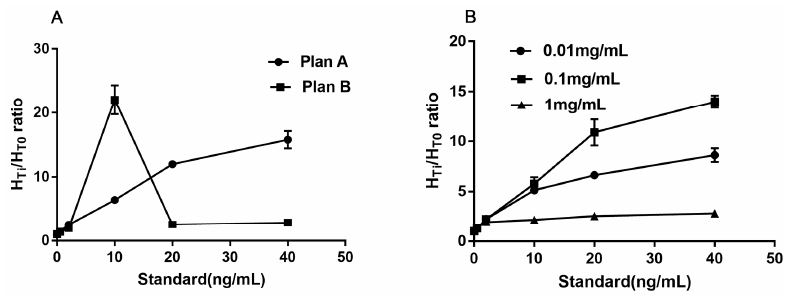
Figure 2. The optimized results of different sprayed speed ( A ) and concentration ( B ).